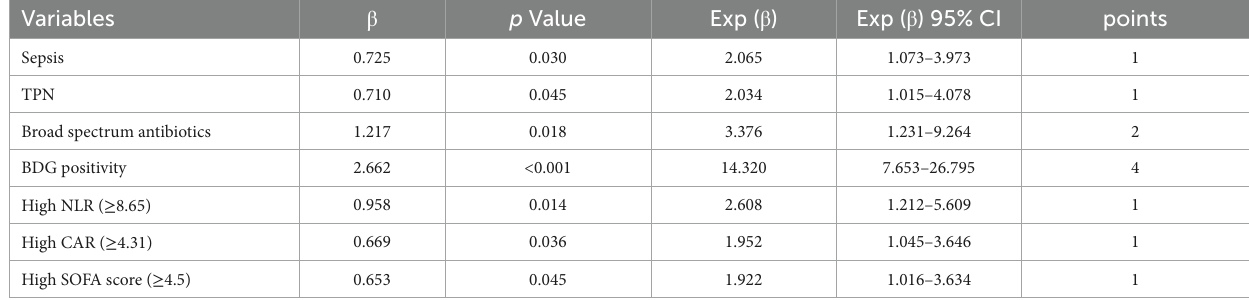
TABLE 3 Multiple logistic regression model and weighed point assignment.